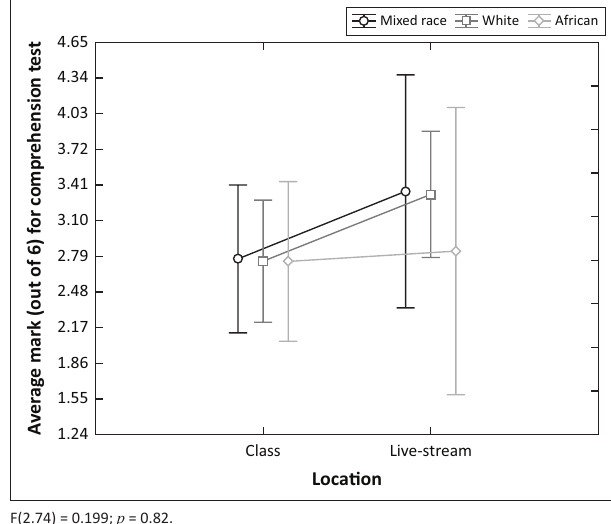
FIGURE 1: Results per race group.